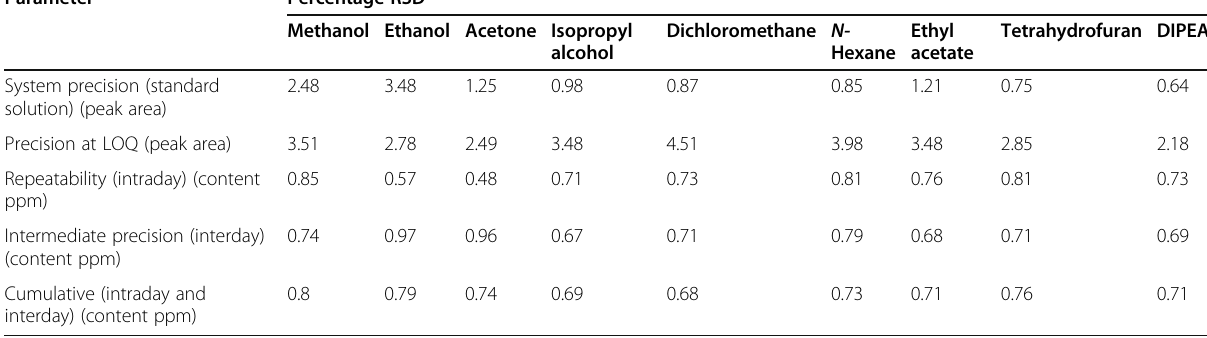
Table 17 Results of precision study for all the solvents Parameter